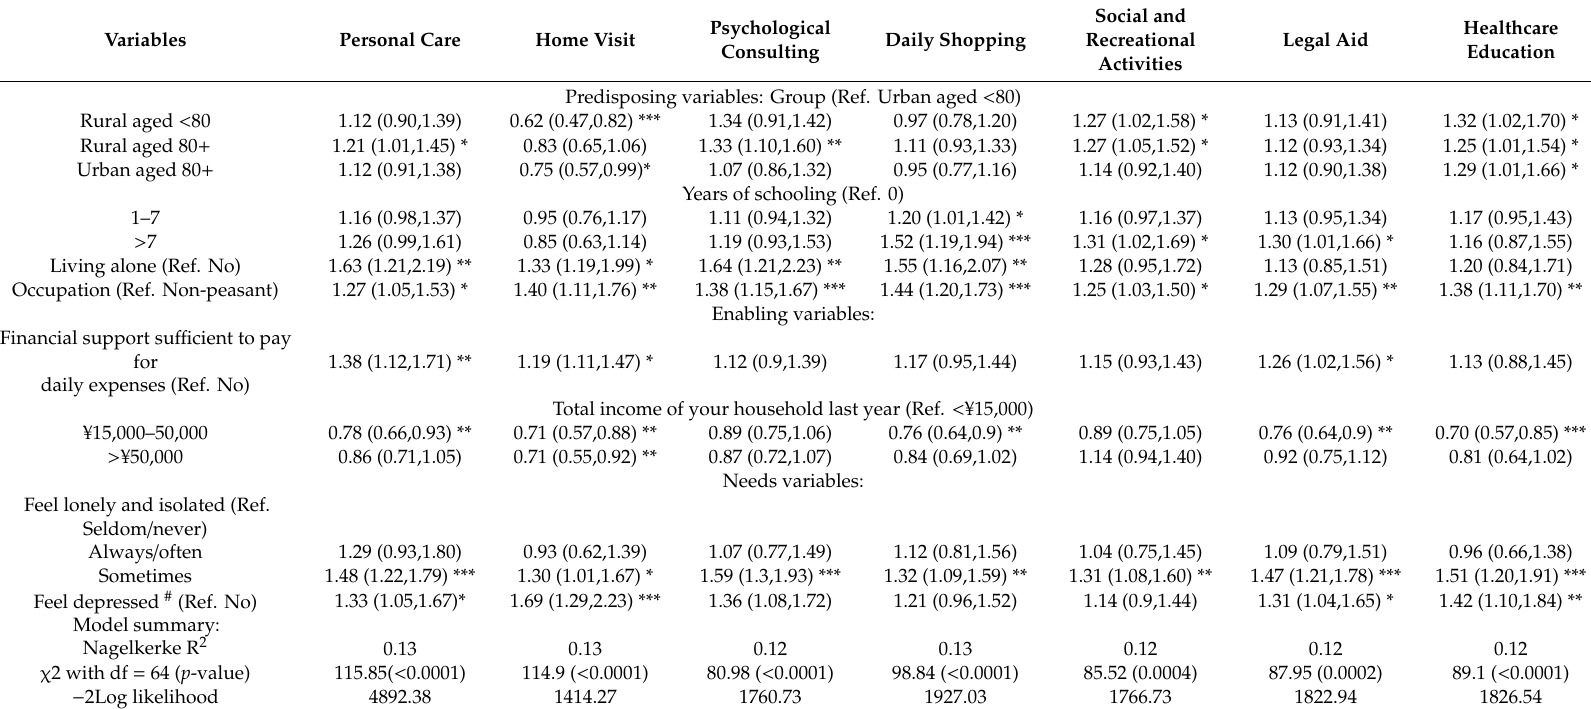
Table 6. Odds ratios of anticipated community-based services (binary logistic